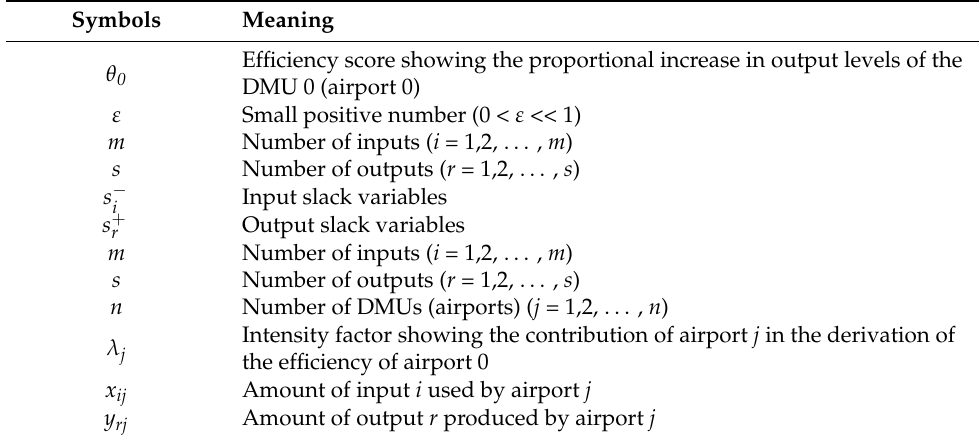
Table 3. Variables associated with the output-oriented model. Symbols Meaning Efficiency score showing the proportional increase in output levels of the θ 0 DMU 0 (airport 0) ε Small positive number (0 < ε << 1) m Number of inputs ( i = 1,2, . . . , m ) s Number of outputs ( r = 1,2, . . . , s ) s − Input slack variables i s + r Output slack variables n Number of DMUs (airports) ( j = 1,2, . . . , n ) Intensity factor showing the contribution of airport j in the derivation of λ j the efficiency of airport 0 x ij Amount of input i used by airport j y rj Amount of output r produced by airport